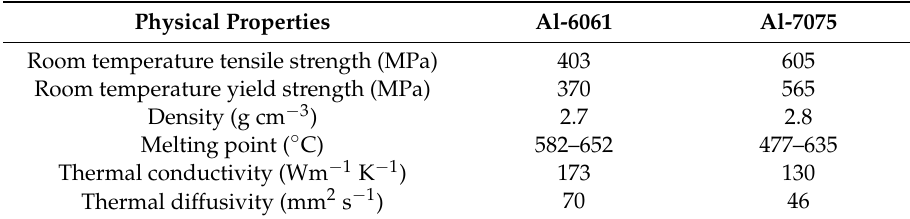
Table 2. Mechanical and physical properties of the aluminum alloys [20–22].